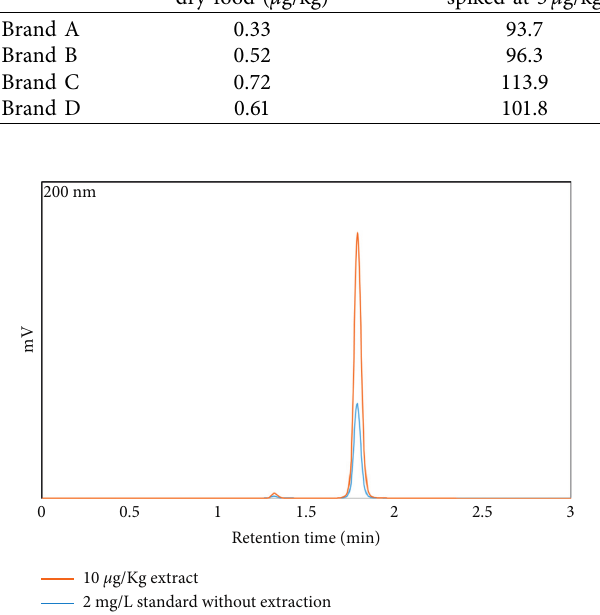
Figure 11: A comparative HPLC chromatogram of standard ac- rylamide 2mg/L and the spiked (10 μ g/kg) pet food sample